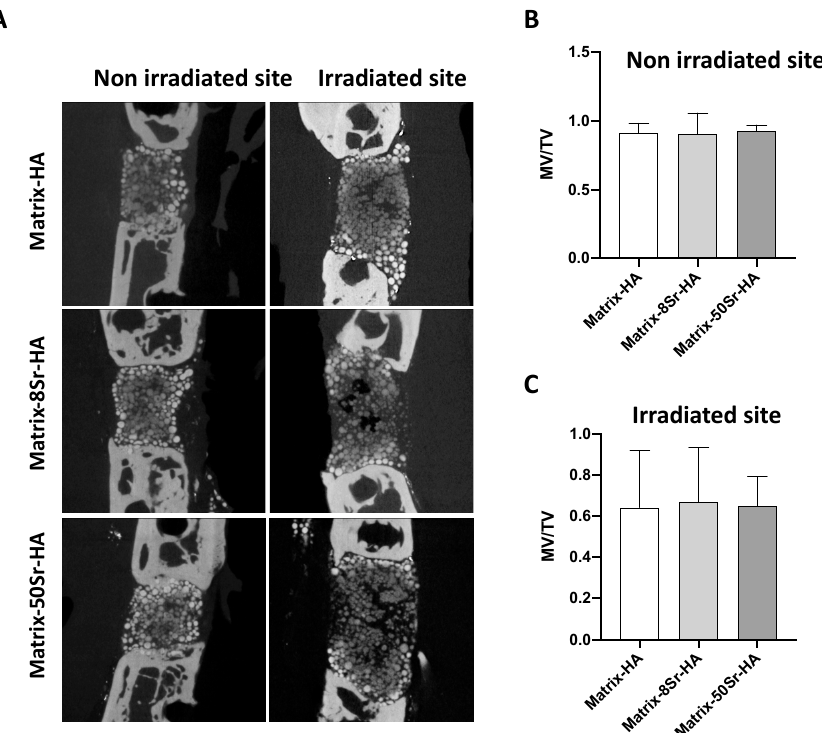
Figure 6. Micro-CT analysis of the tissue formed within the Matrix HA groups supplemented or not with strontium in the rat segmental bone defect models after irradiation procedure: ( A ) Representative Micro-CT images of the three groups of microbeads (Matrix-HA, Matrix-8Sr-HA, and Matrix-50Sr-HA) after 12 weeks of implantation of the microbeads within the segmental bone defects without or